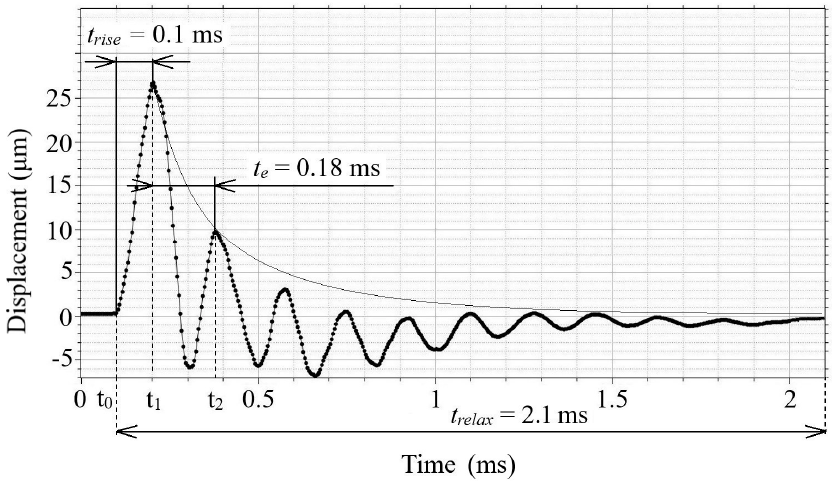
Figure 3. Vibration profile of 1 mm thick aluminum emitter membrane excited by gas discharge electric pulse.